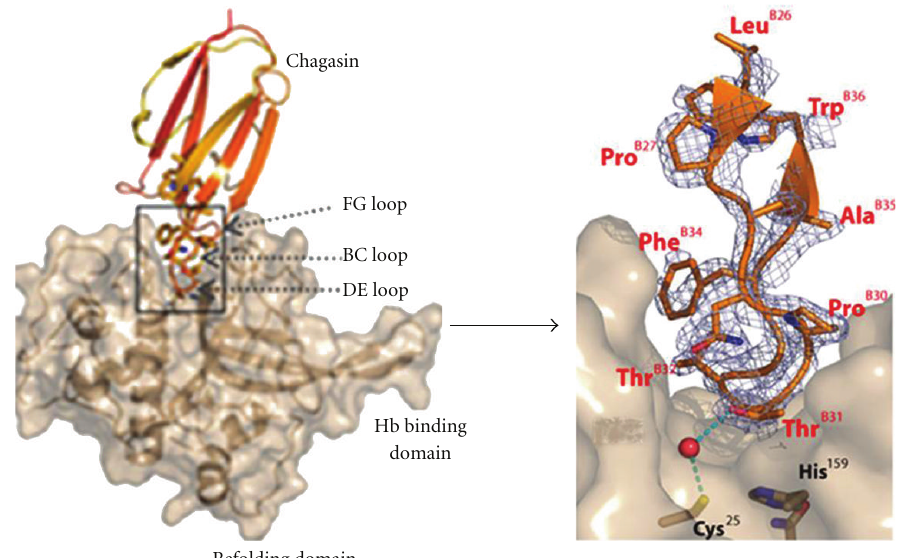
Figure 7: Structure of falcipain-2-chagasin complex: overall structure of chagasin with falcipain-2, chagasin in red and falcipain-2 in gold. Key binding interactions between chagasin and falcipain-2 can be seen